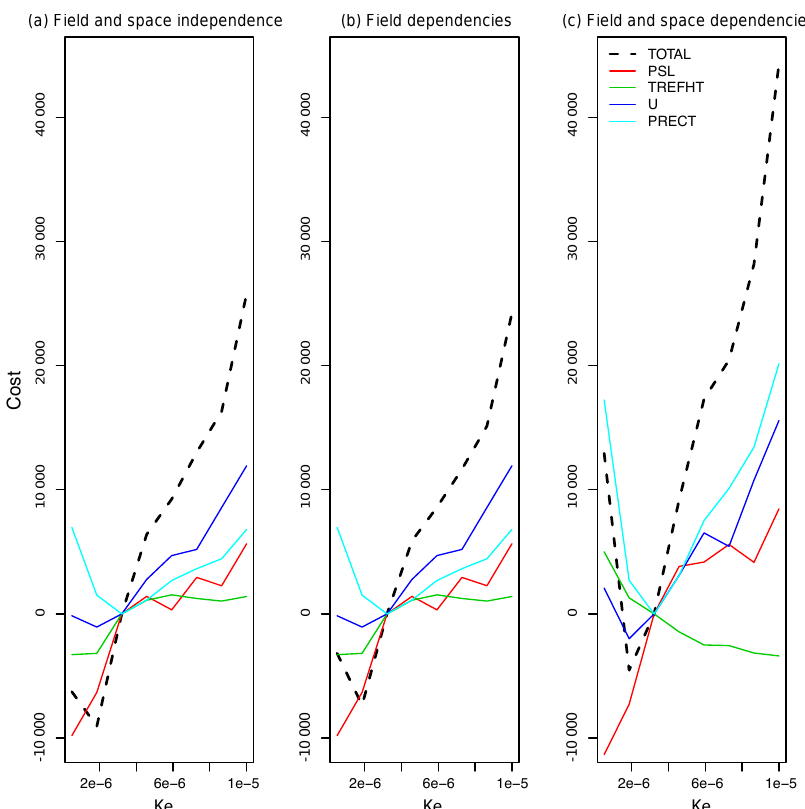
Figure 6. Different field contributions to the GMRF-based costs for a slice of Fig. 5 where c0 = 0.0035. Cost values are relative to the default parameter setting for ke . Note that total cost (black dashed line) is a weighted sum of field contributions as given by S − 1 with contributions from sea level pressure (PSL, red line), 2m air temperature (TREFHT, green line), 200-millibar zonal winds ( U , blue line), and total precipitation (PRECT, cyan